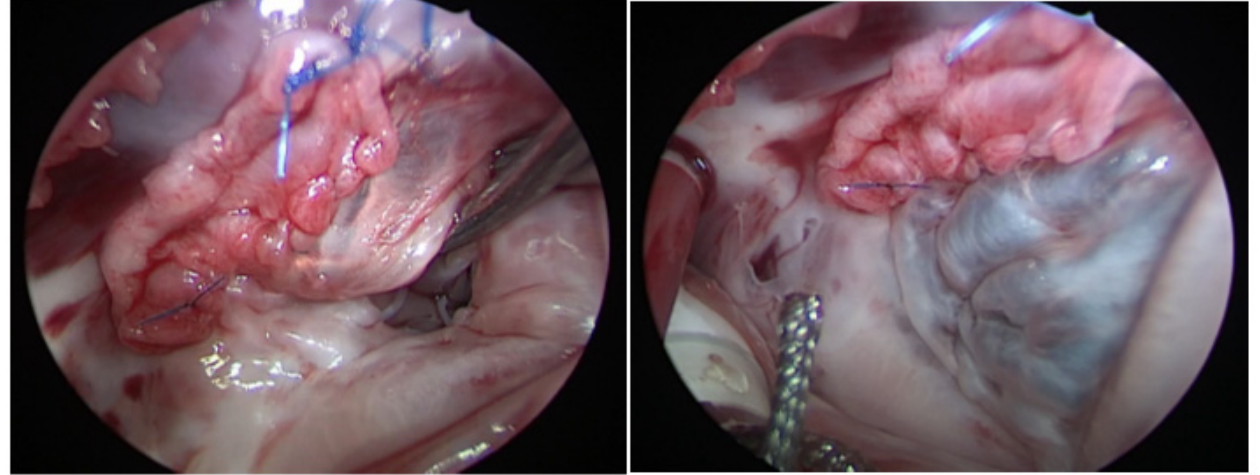
Figure 3. ( Right ) TV after reconstruction and augmentation of the leaflets, the black arrow is pointing to the pericardial patch used to perform the augmentation. ( Left ) TV after injecting water in the RV for the water probe showing a competent TV. RV: right ventricle, TV: tricuspid valve.